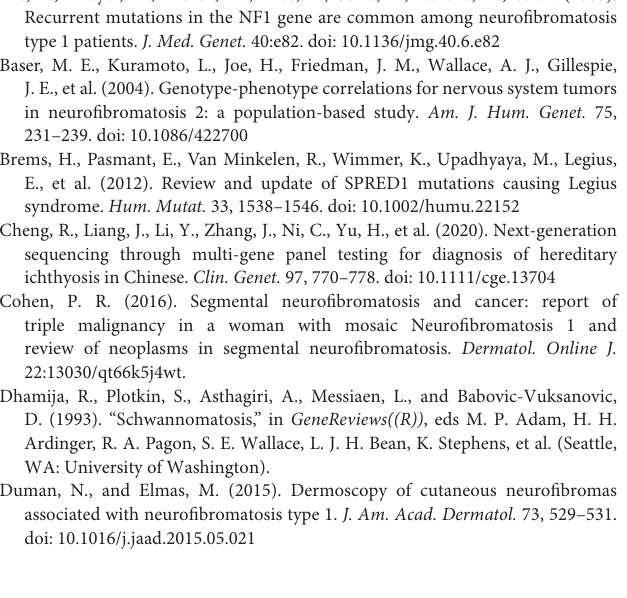
Supplementary Figure 2 | Pictures of CALMs by reflectance confocal microscopy and dermoscopy examination. High refractive index particles of different sizes in the superficial dermis (red arrow) significantly increased pigment contents in the stratum layer (yellow arrows) under RCM (A) . Regular sepia grid-like pigmentation under a microscope with clear boundaries by dermoscopy (100X) (B) . Supplementary Figure 3 | Histological and immunohistochemical manifestations of cutaneous neurofibromas in the proband from family 4. A large and isolated nodule in the dermis (A , 10X ) and wavy spindle cell changes ( D , 40X). Strong and diffuse CD34 staining ( B , 10X) and strong CD34 staining in the tumor cell cytoplasm ( E , 40X). Scattered S100 staining ( C , 10X) and S100 staining in tumor cell nuclei ( F , 40X). Supplementary Figure 4 | Histological and immunohistochemical manifestations of skin plaques in the proband from family 5. The nodules interconnected with each other ( A , 10X) and the change in swirly spindle cells ( D , 40X ) . Scattered CD34 staining ( B , 10X) and weak CD34 staining in the tumor cell cytoplasm ( E , 40X). Strong and diffuse S100 staining ( C , 10X) and strong S100 staining in the tumor cell nuclei ( F ,